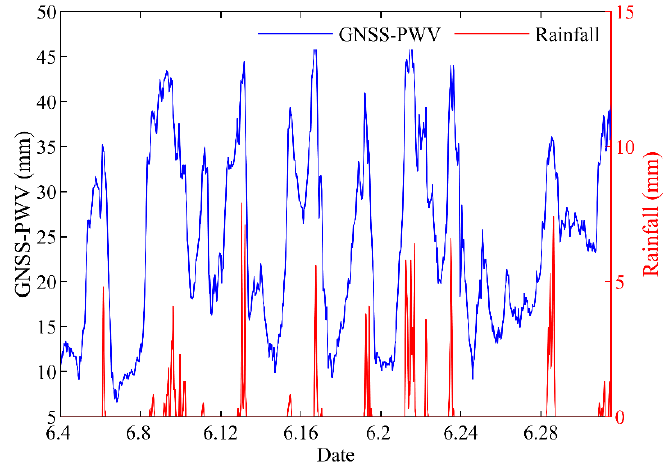
Figure 4. Variation in GNSS-PWV before rainfall events in June 2015 at the 726140-54742-VTD7 sta- tion. Table 4. Definition of the three prediction factors.